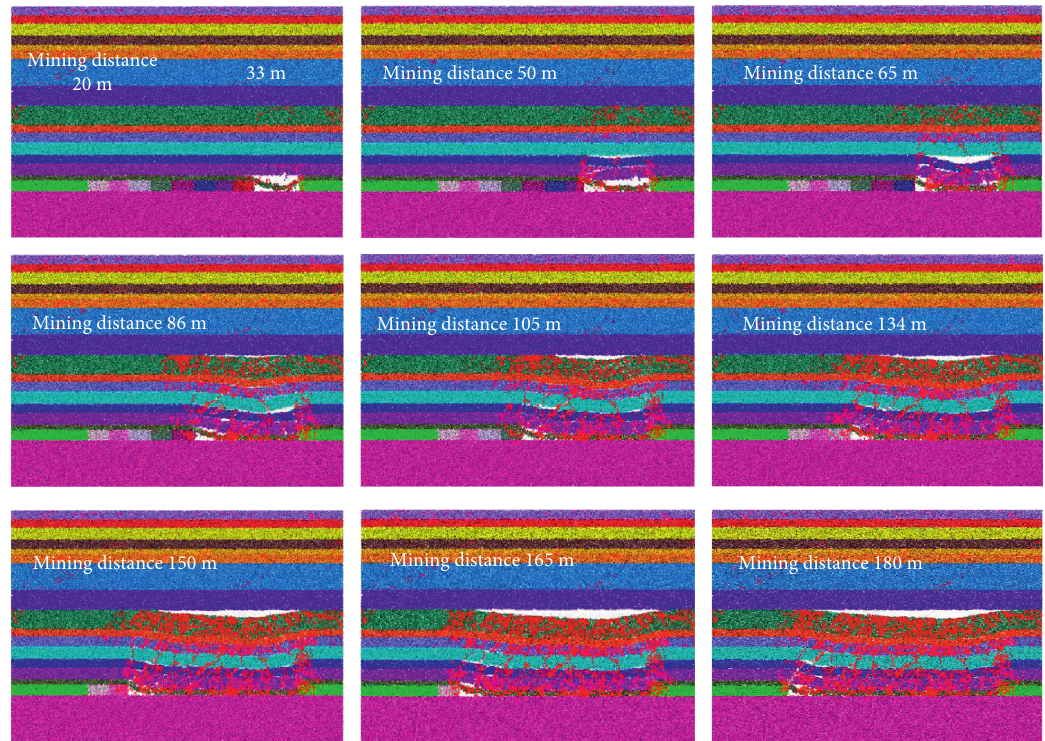
Figure 15: Caving characteristics of mining overlying rock of scheme